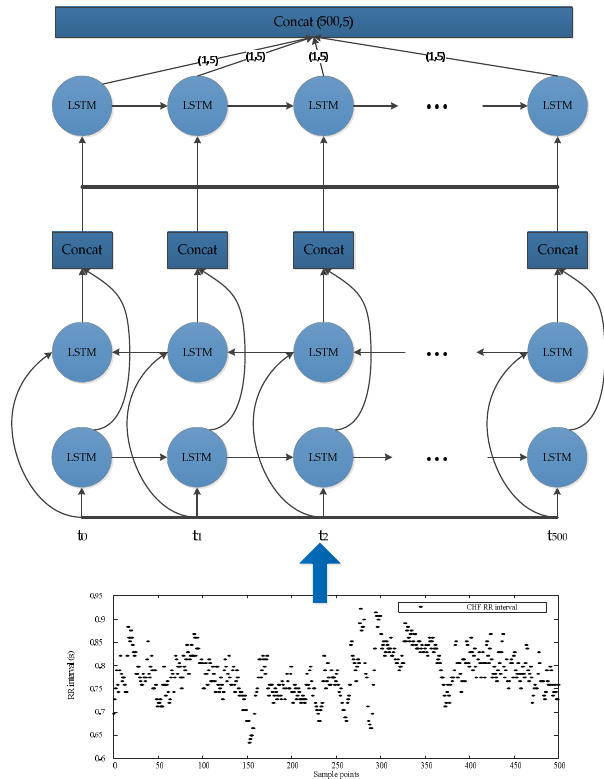
Figure 5. The LSTM network used in the module (with many-to-many structure, the input data is 500 RR interval segments).